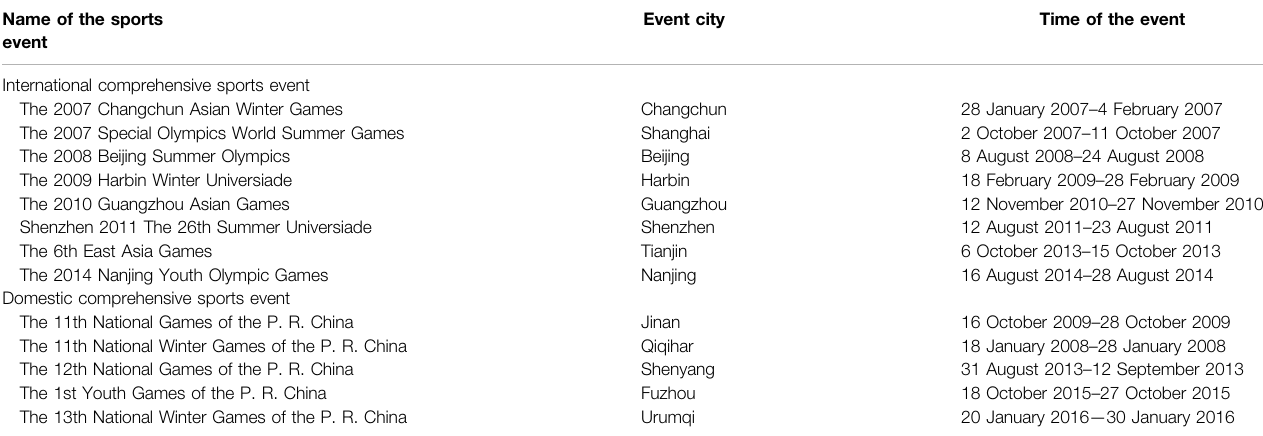
TABLE 1 | Previous comprehensive sports events hosted by mainland China.